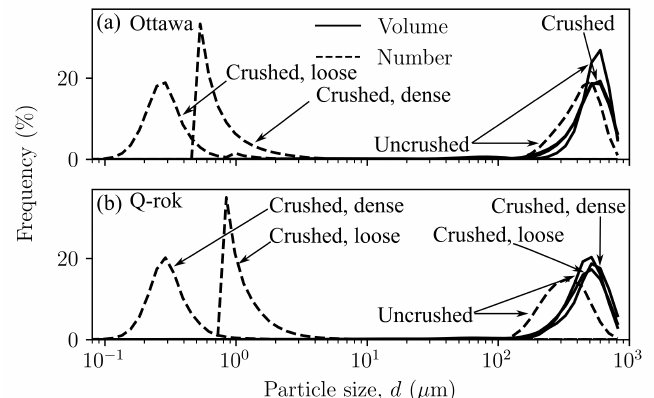
Figure 8. Particle size evolution in dense and loose specimens of ( a ) Ottawa sand and ( b ) Q-Rok subjected to 1D compression loading, shown as volume and number